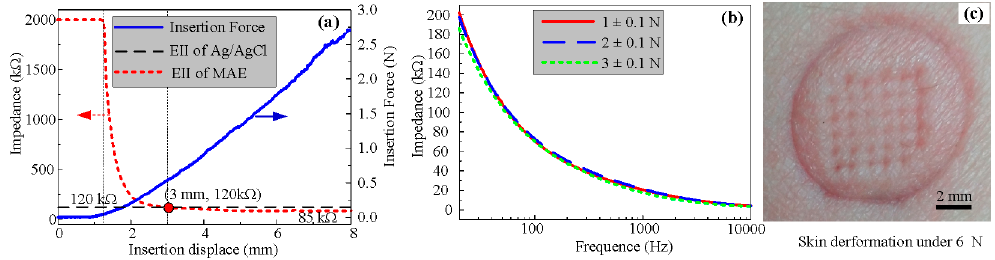
Figure 7. Insertion force and EII test. ( a ) EII during the insertion process, ( b ) EII under different input current frequency, and ( c ) skin deformation under the impression force of 6N.